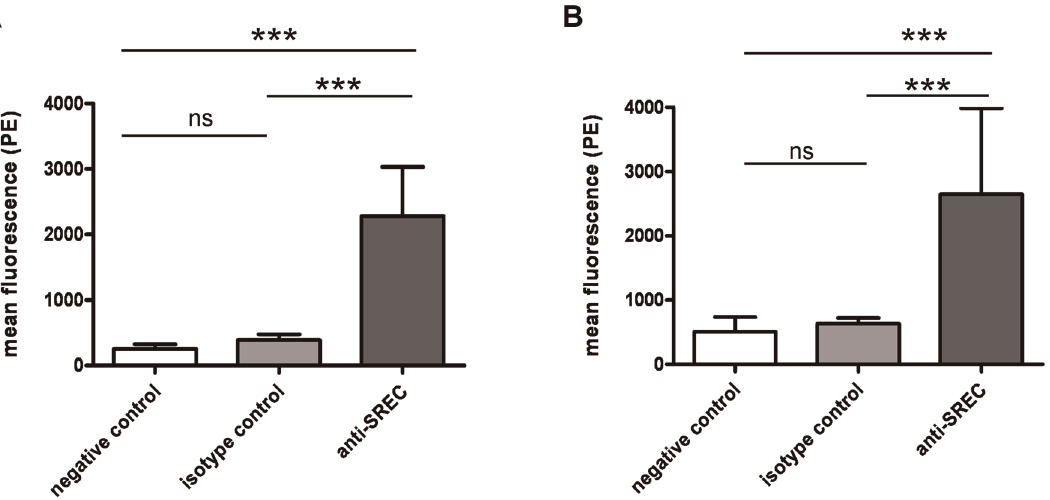
Figure 1. SREC-I on nasal epithelila cells. Surface exposure of SREC-I on HNECs and CRNECs was monitored by FACS with the same anti-human SREC-I antibody and isotype control. Statistical evaluation on HNECs (A) and on CRNECs (B). Data represent means 6 SD of 3 or 4 independent experiments. Statistical analysis was performed by Student’s t-test. Significant differences are indicated by one ( P , 0.05), two ( P , 0.01), or three ( P , 0.001) asterisks ( *